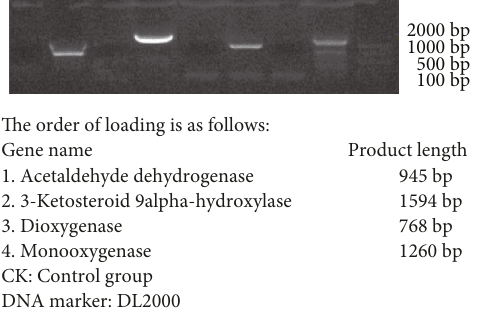
Figure 7: RT-PCR agarose gel